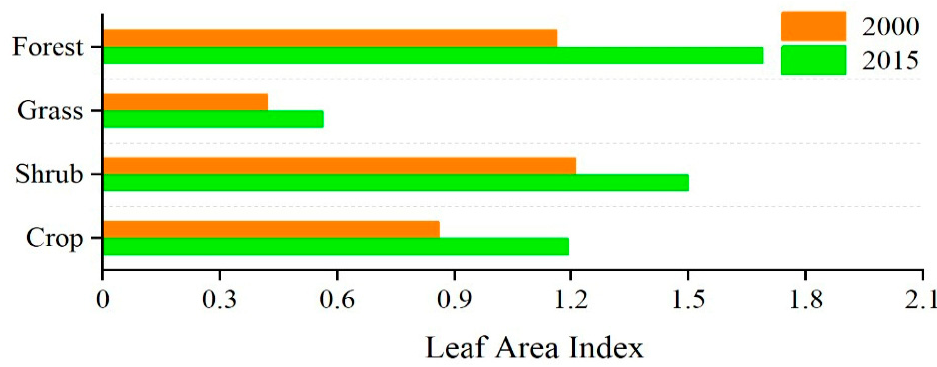
Figure 2. Comparison of the calculated average LAI values for different vegetation types between 2000 and 2015 on the LP.